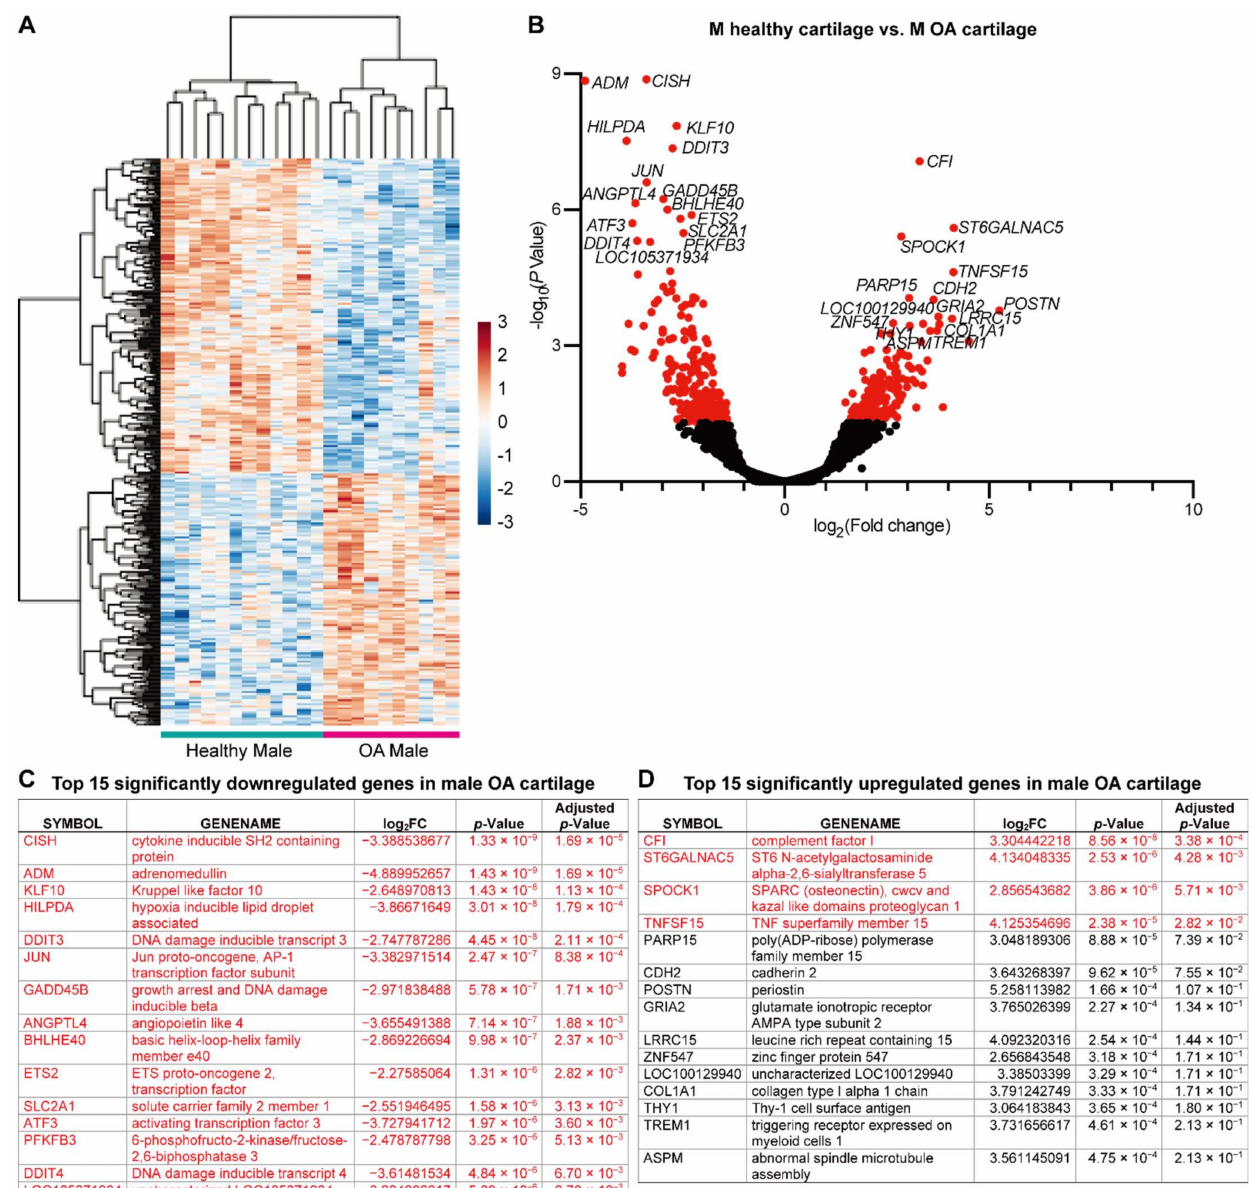
Figure 3. The DEGs detected between male healthy and OA cartilage. ( A ) Heatmap and ( B ) volcano diagrams for DEG visualization. DEGs with a p -value less than 0.05 are highlighted in red. ( C ) Top 15 genes significantly downregulated in male cartilage in response to OA. ( D ) Top 15 genes significantly upregulated in male cartilage in response to OA. DEGs with an adjusted p -value less than 0.05 are highlighted in